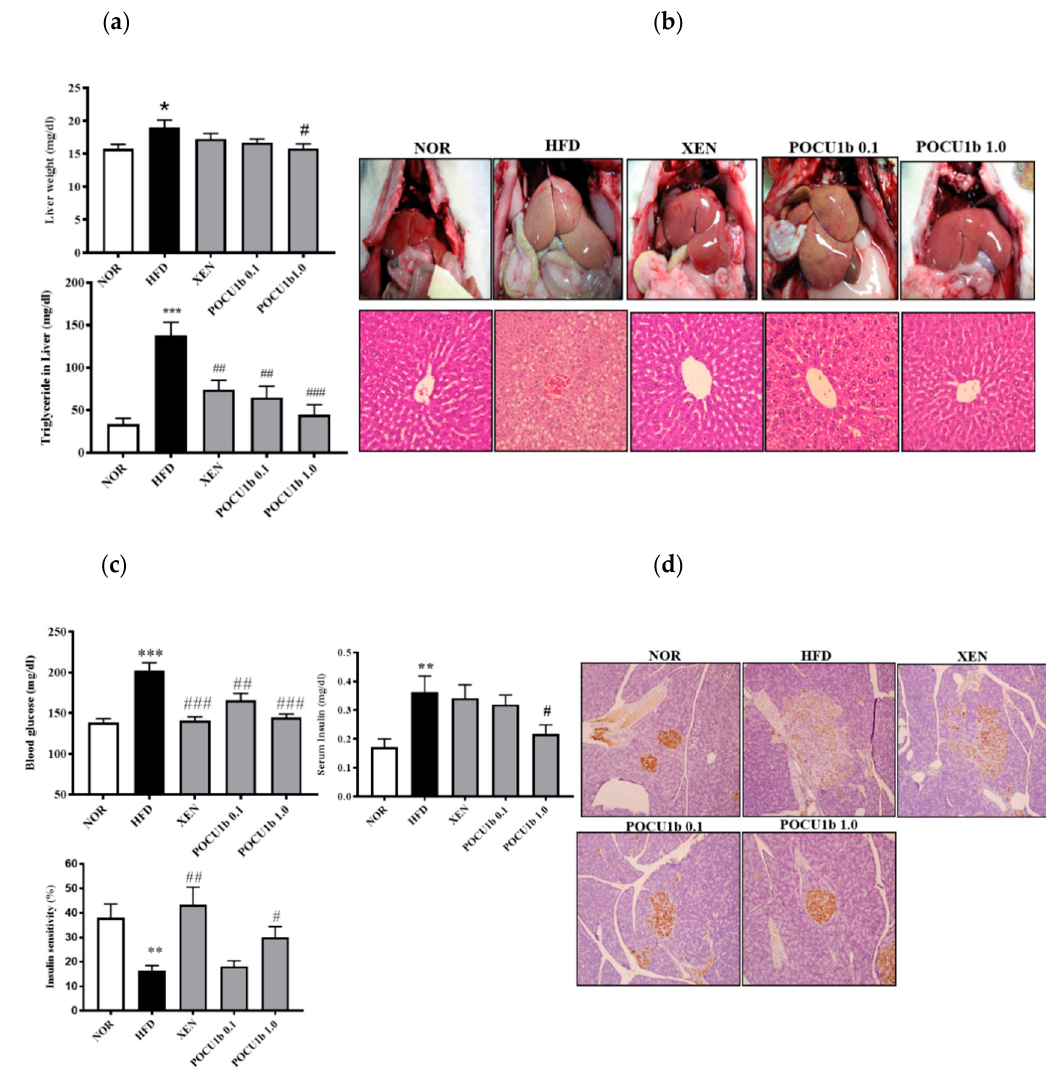
Figure 6. Effects of POCU1b on hepatic lipid accumulation and insulin resistance in HFD ‐ fed rats. ( a ) Liver weight and liver TG content. ( b ) Gross macroscopic evaluation of the liver and photomicrographs of H&E-stained liver tissues. ( c ) Blood glucose, insulin levels, and insulin sensitivity. ( d ) Insulin secretion in the pancreas. * p < 0.05, ** p < 0.01, *** p < 0.001 vs. NOR, # p < 0.05, ## p < 0.01, ### p < 0.001 vs HFD. ( b, d ) Original magnification 200×.